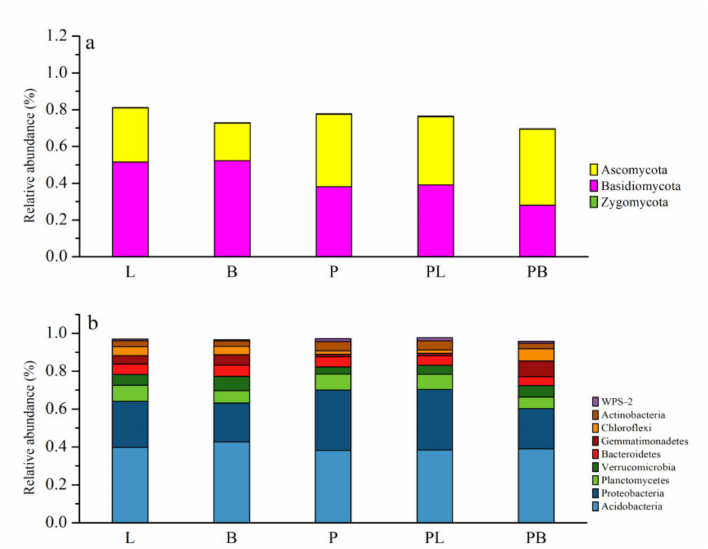
Figure 2. Relative abundance of fungal ( a ) and bacterial species ( b ). The transverse coordinate is the sample name and the longitudinal coordinate is the relative abundance. The figure shows species with a relative abundance of more than 1% in fungal and bacterial communities. Details are described in Figure 1.